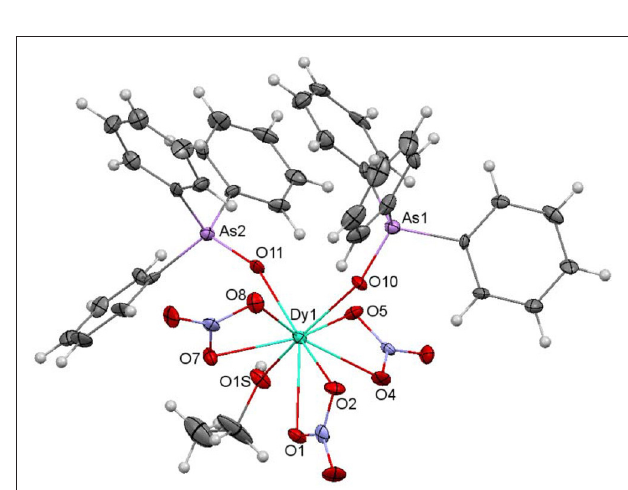
FIGURE 3 | Coordination polyhedron for Dy in 2 , illustrating the distorted spherical capped square antiprism geometry shown by the metal ion in 1 and 2 .